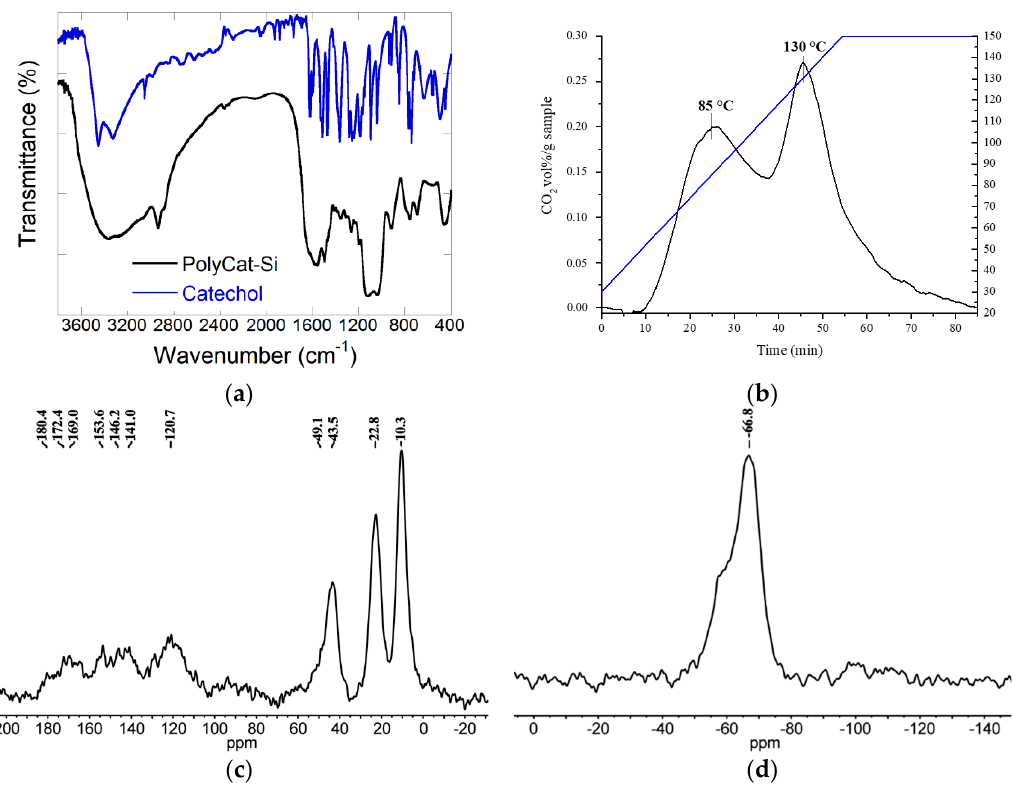
Figure 1. ( a ) FT-IR spectra of catechol and PolyCat-Si; ( b ) Temperature programmed desorption of CO 2 (TPD-CO 2 ) of PolyCat-Si; ( c ) 13 C MAS NMR spectrum; and ( d ) 29 Si NMR spectrum of PolyCat-Si.